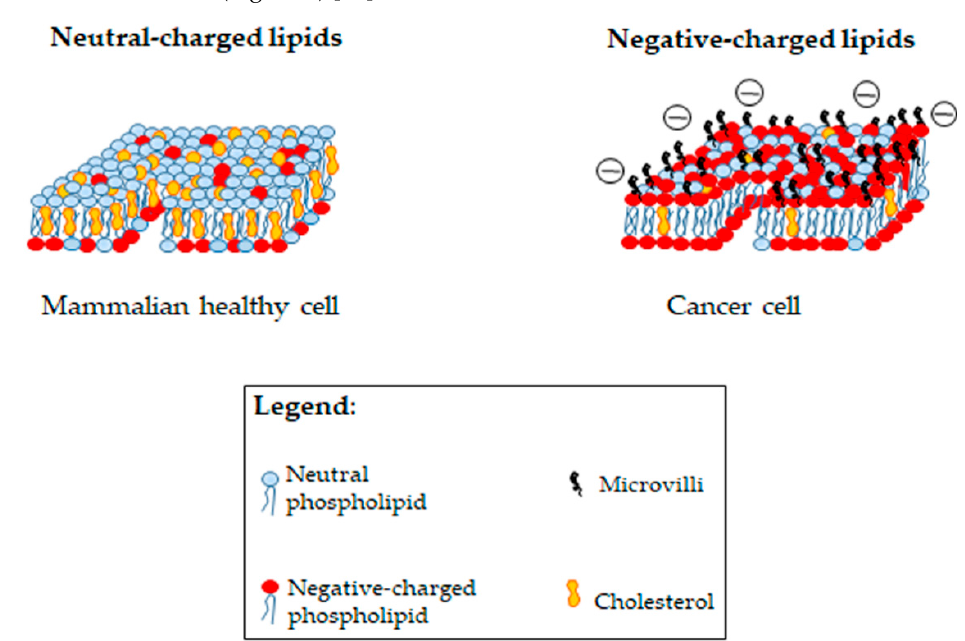
Figure 2. Comparison among membrane lipid composition of healthy mammalian cells and cancer cells.